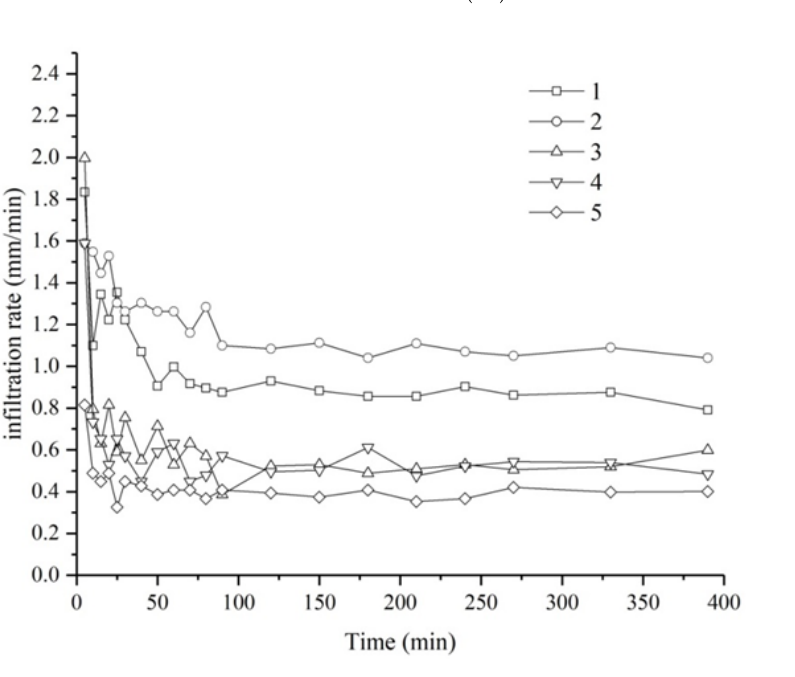
Figure 5. Variation characteristics of soil water infiltration rate.